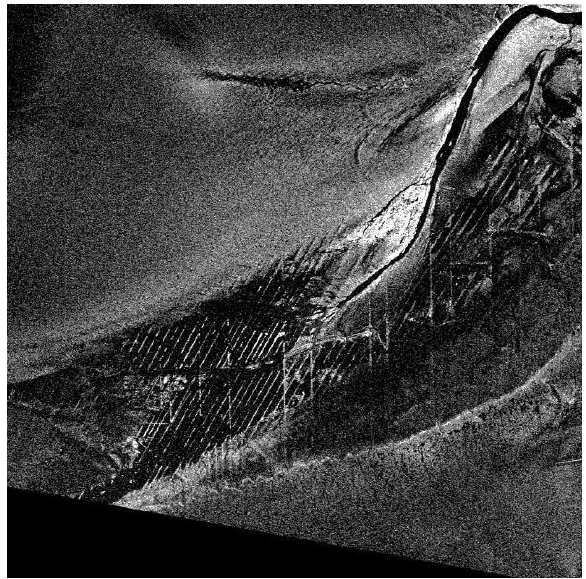
Figure 8. Subsection (1000 m × 1000 m) of a TanDEM-X staring spotlight scene acquired on November 21, 2014, north of Pellworm island and showing in its lower center the same area as in Fig. 9. © DLR 2014.